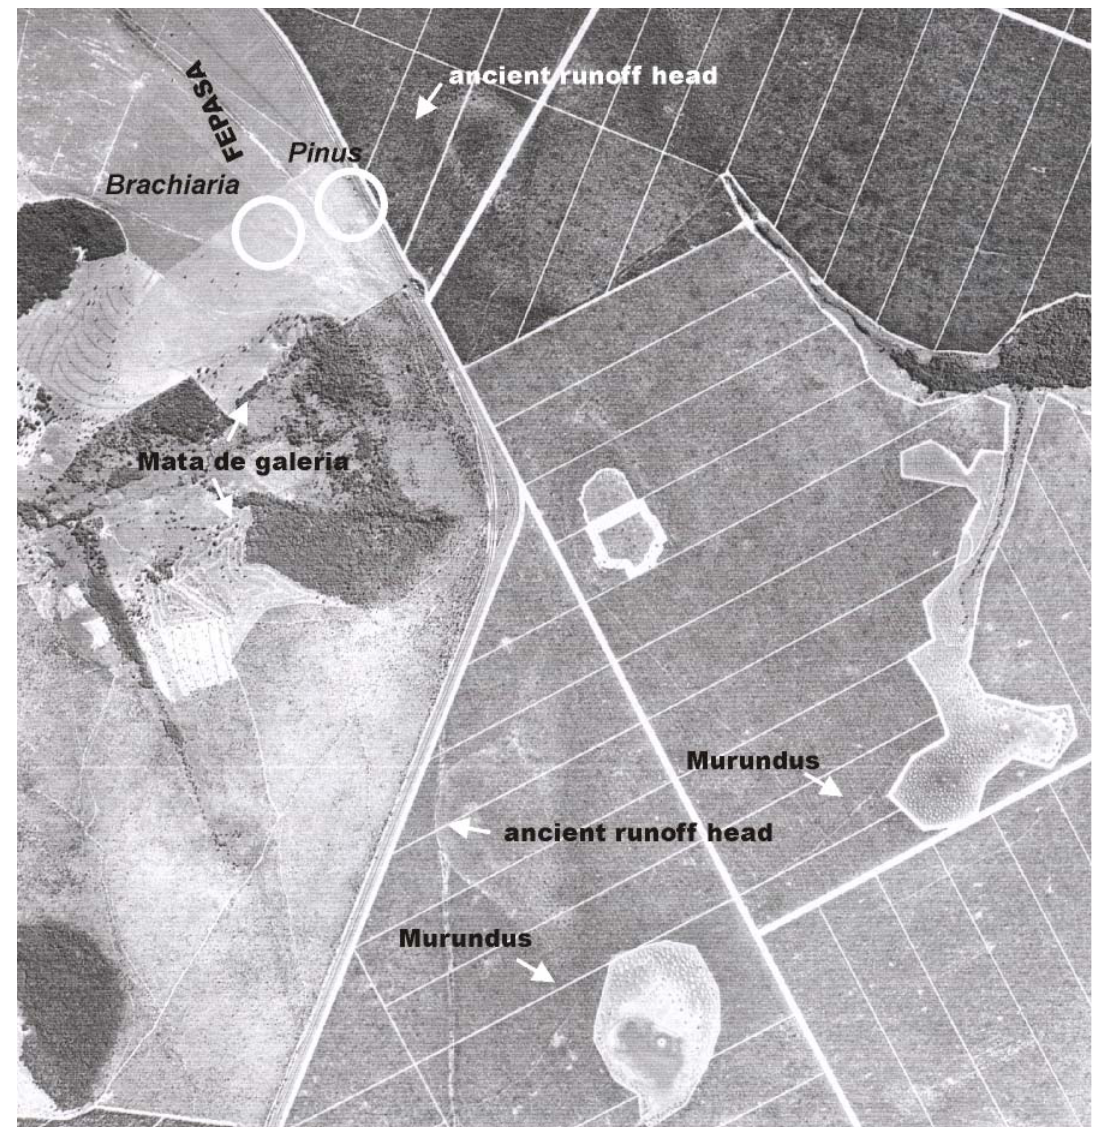
Figure 3. Aerial photograph from 1979, showing several Cerrado vegetation forms and ancient runoff heads which were already cultivated at the